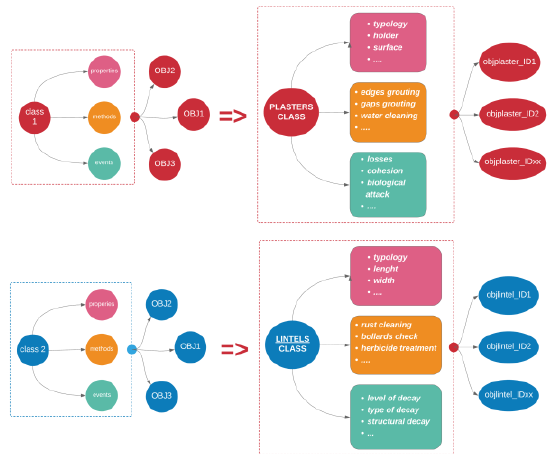
Figure 3: Conceptual model of the object-oriented system used for the implementation of the RDBMS.